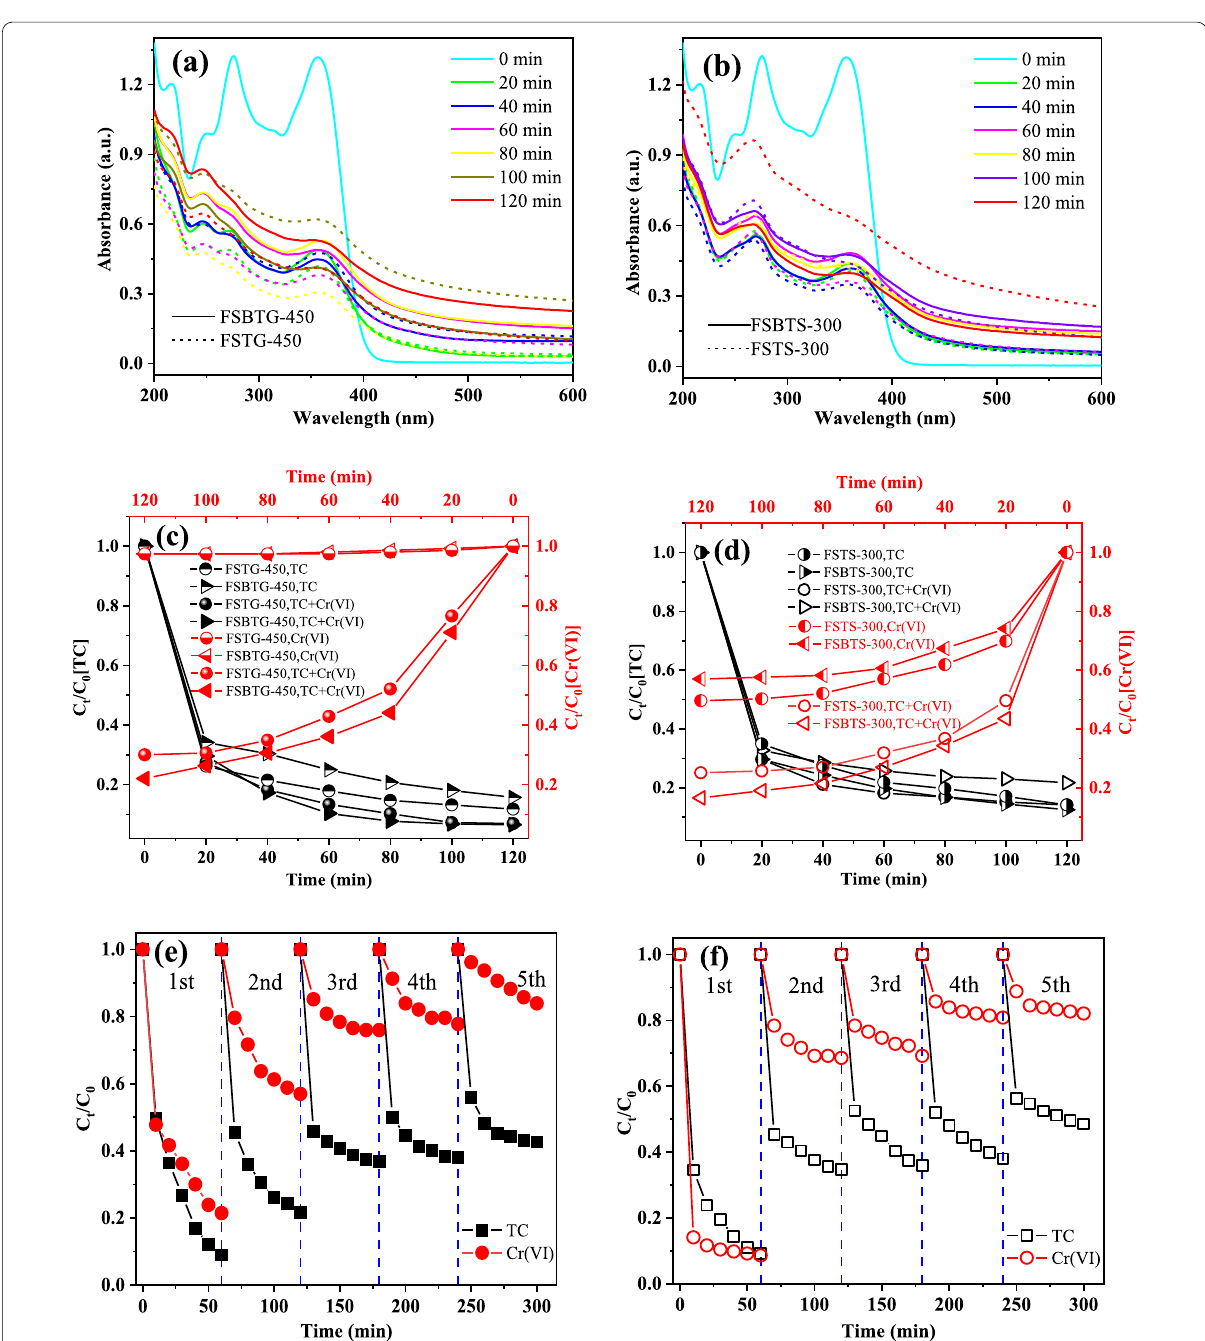
Fig. 6 UV–vis spectra, simultaneous TC photodegradation with Cr(VI) removal in the TC/Cr(VI) combined pollution systems, recycling experiments using FSBTG-450 photocatalysts ( a , c , e ) and FSBTS-300 photocatalysts ( b , d , f